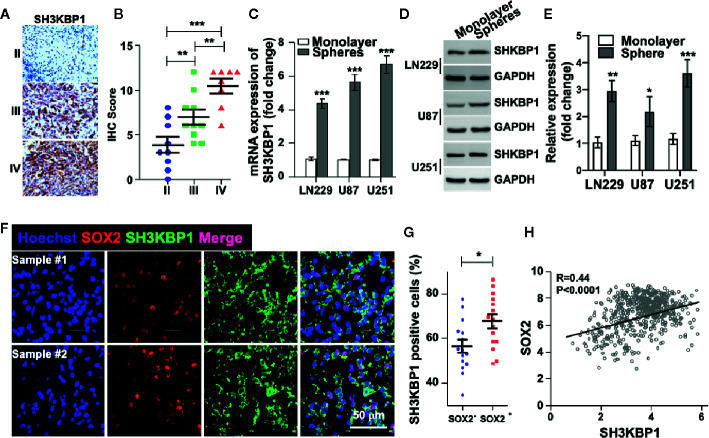
SH3KBP1 is elevated in glioma stem cells (GSCs). (A) Representative images of immunohistochemistry (IHC) staining of SH3KBP1 from 27 gliomas specimens. (B) Quantitative data for (A). (C) Real-time PCR analysis showing the expression of SH3KBP1 in tumor spheres and their corresponding monolayer indicated cells. (D) Western blot assay was performed to analyze the expression pattern of SH3KBP1 in tumor spheres and their corresponding monolayer indicated cells. (E) Quantification data for (D). (F) Representative images of immunofluorescence staining of SH3KBP1 and SOX2 in two independent Glioblastoma (GBM) specimens. (G) Five randomly selected microscope fields of each tumor were quantified. (H) Pearson correlation between SH3KBP1 and SOX2 mRNA expression in the CGGA Glioma dataset. Pearson correlation coefficients are shown in the matrix. *, ** and *** indicate as p < 0.05, p < 0.005 and p < 0.001 respectively.